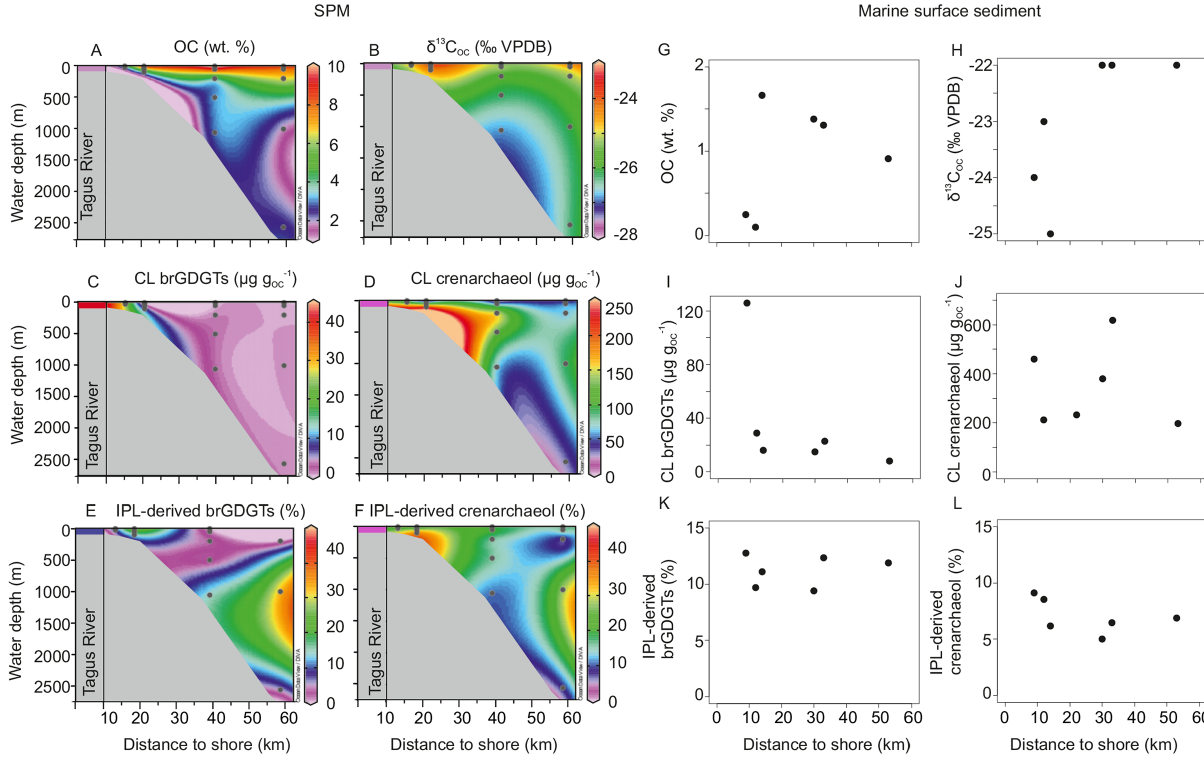
Figure 8. OC content, δ 13 C OC , CL brGDGT and CL crenarchaeol concentrations, and the percentage of IPL-derived brGDGTs and crenar- chaeol for marine SPM (a–f) and for marine surface sediments (g–l) . The average values of the Tagus River SPM are also shown.